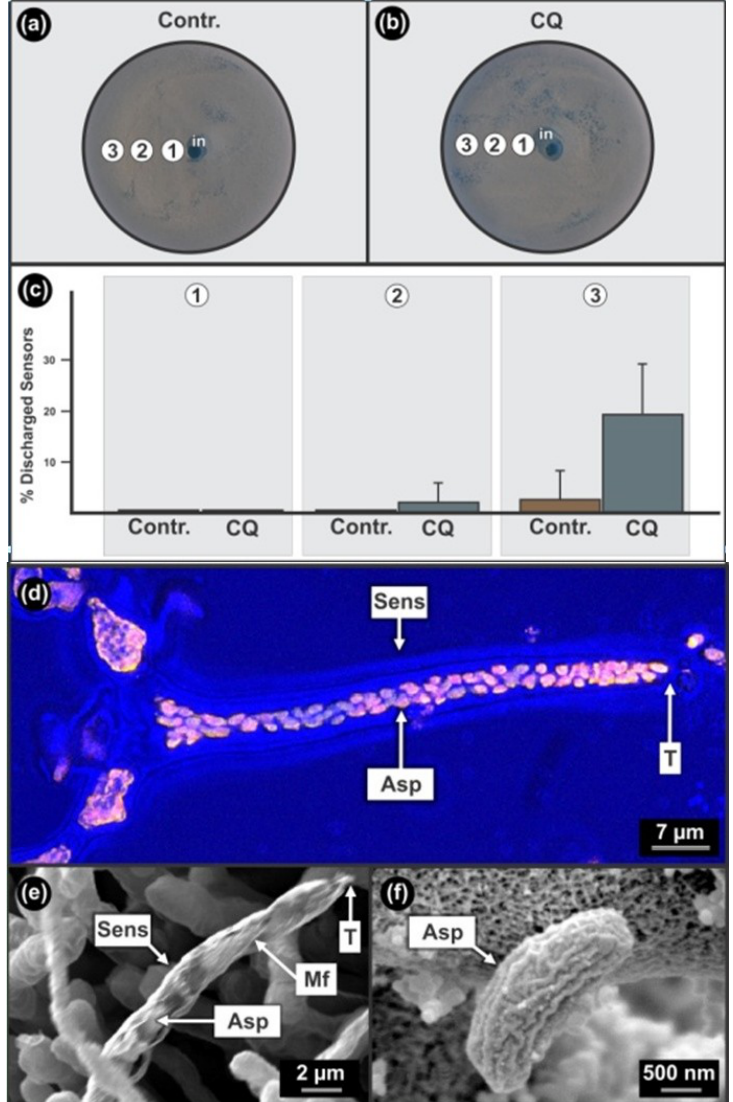
Figure 4. Sensors of Dipodascopsis uninucleata sensing Chloroquine by ascospore discharge. ( a ) Control: Bio-assay plate showing three areas (1,2,3) that coincide with a concomitant decrease in concentration of ethanol (EtOH) alone. ( b ) CQ: Bio-assay plate showing three areas (1,2,3) that coincide with a concomitant decrease in the concentration of chloroquine in combination with EtOH. ( c ) A graph showing changes in percentage discharged sensors over a decreasing gradient (from 1 to 3) of EtOH alone (Contr.) and EtOH in combination with chloroquine (CQ). ( d ) A Confocal Laser Scanning Microscope (CLSM) micrograph of an Orange G treated fluorescing sensor of D. uninucleata. ( e ) Disassembly of the sensor by Argon (Ar + ) etching and visualised with Nano Scanning Auger Microscopy (NanoSAM) in SEM mode showing micro-fibrils coiled around the sensor. ( f ) SEM micrograph of an ascospore showing ascospore longitudinal grooves necessary for smart sensor mechanics. Asp, ascospore; Contr., control; CQ, Chloroquine in EtOH solution; Mf, micro-fibrils, Sens, sensor; T, tip of sensor; 1,2,3, zones on bio-assay plates. Part of this figure ( i.e. , (e)) is available in a video lecture posted on the website of Translational Biomedicine and are reproduced with permission